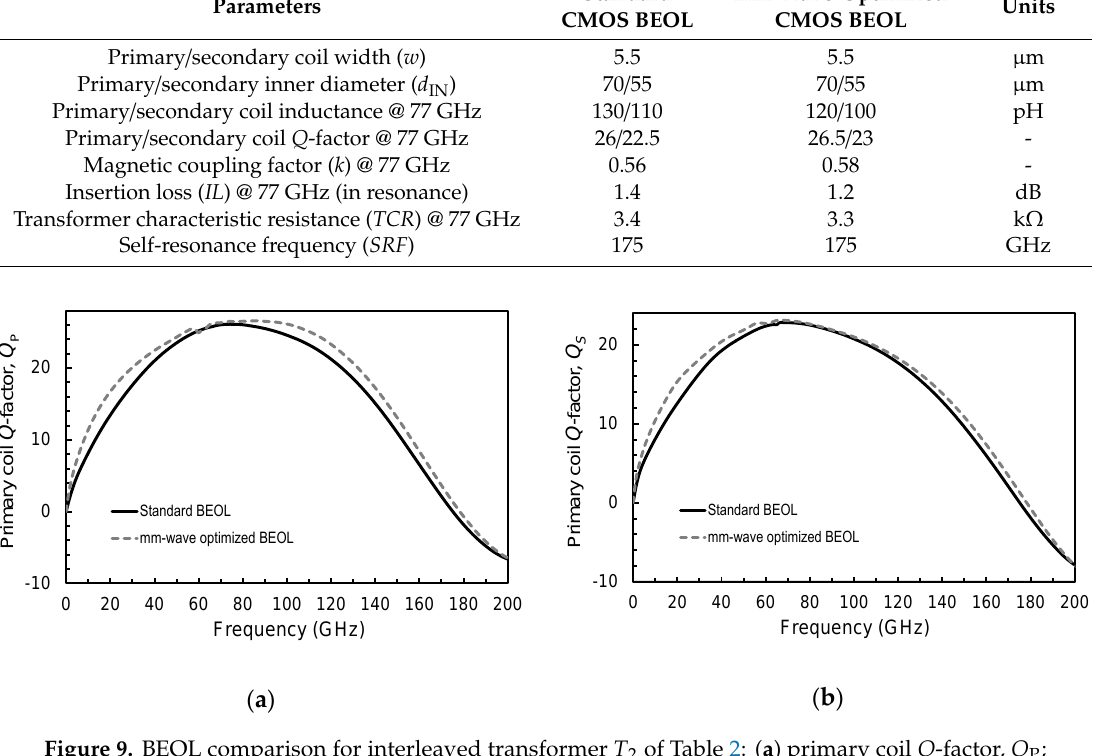
Table 2. Geometrical and performance parameter comparison for the interleaved transformer T 2 .